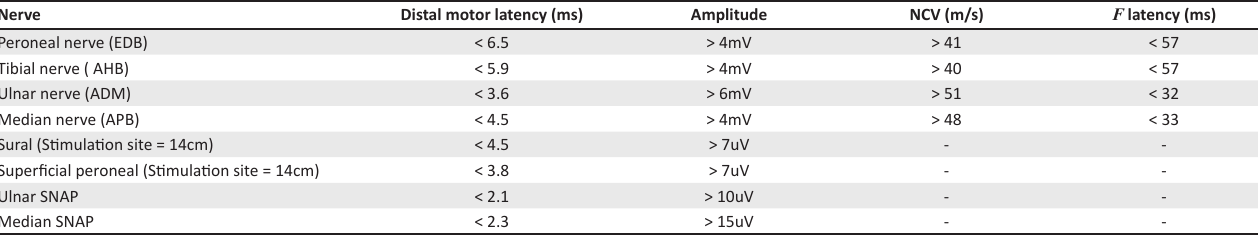
TABLE 4: Normal values for Inkosi Albert Luthuli Central Hospital Electrophysiology Laboratory. Nerve